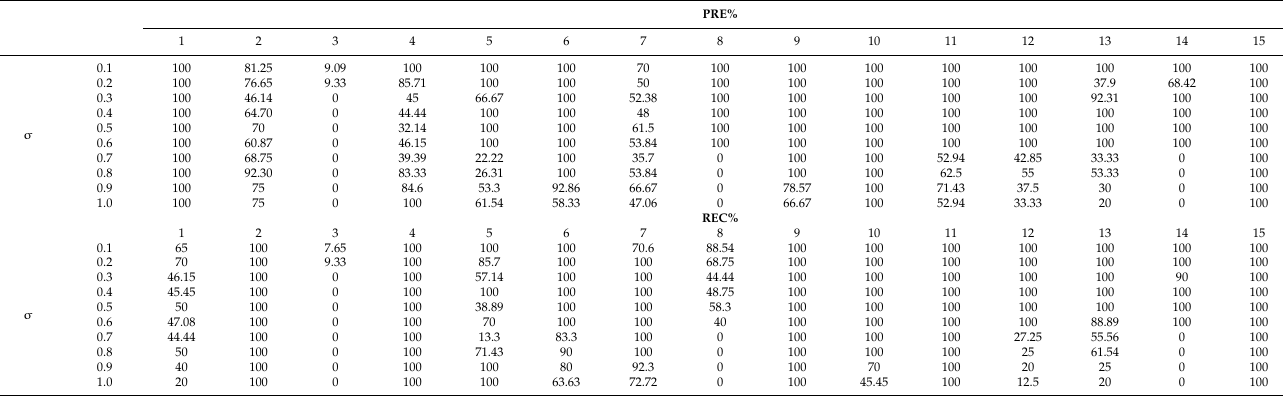
Table 2. Influence of smoothing factor on precision and